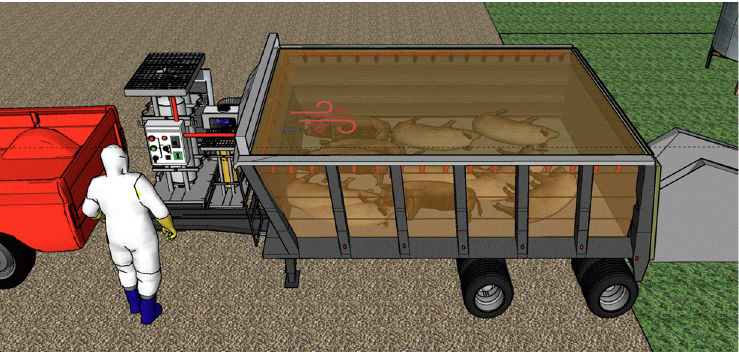
Figure 7. Direct ‐ fired heater is used for the inactivation of pathogens in carcass after depopulation.